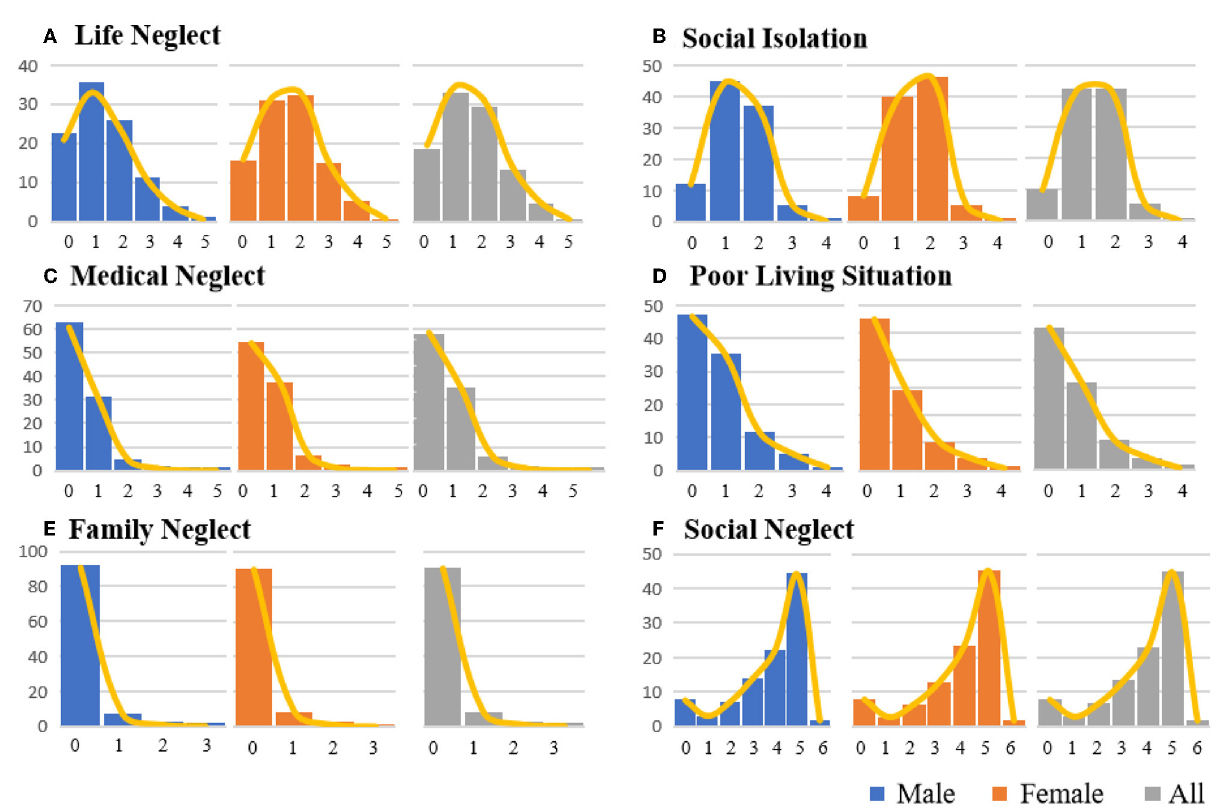
FIGURE1 Score distribution by percentage in different domains of neglect. (A – F) Present the distribution of scores in each domain, and each color represents the same population in CLHLS, blue for male participants, orange for female participants, and gray for the whole population. The line in yellow presents the trend of the distribution in the score of each dimension. The number on the left is the percentage of the population.